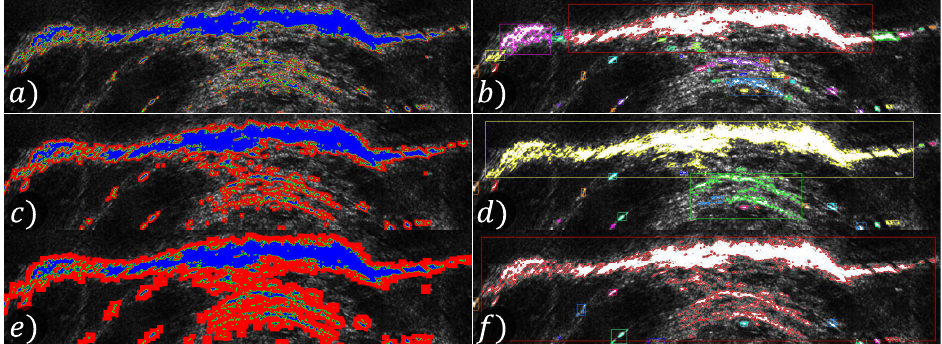
Figure 5. Segment extraction step. After detecting the intensity peaks, a search for connected pixels is performed. These images show the segment extraction of the same image changing the parameter D seg . The images on the left show the pixel search process; the visited and those included on the segment pixels are shown in blue, the segment contour pixels are shown in green and the pixels visited on the search to merge nearby segments are shown in red. The right images show the extracted segments. D seg = 1 was used in ( a,b ); D seg = 4 was used in ( c,d ) and D seg = 10 was used in ( e,f